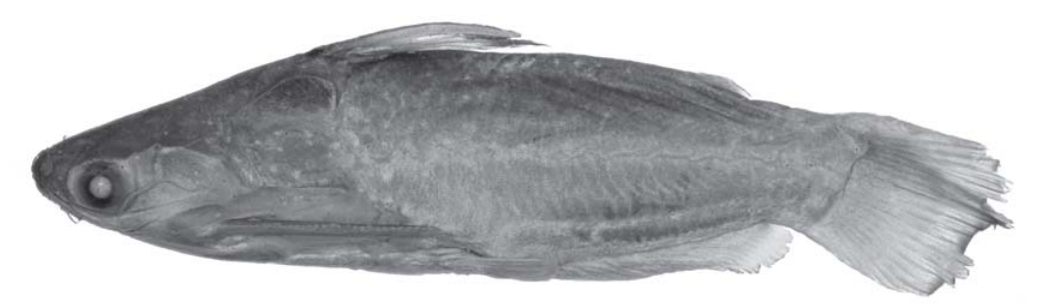
Fig. 11. Auchenipterichthys thoracatus , FMNH 57798, 89 mm SL; Brazil, Maciel, rio Guaporé